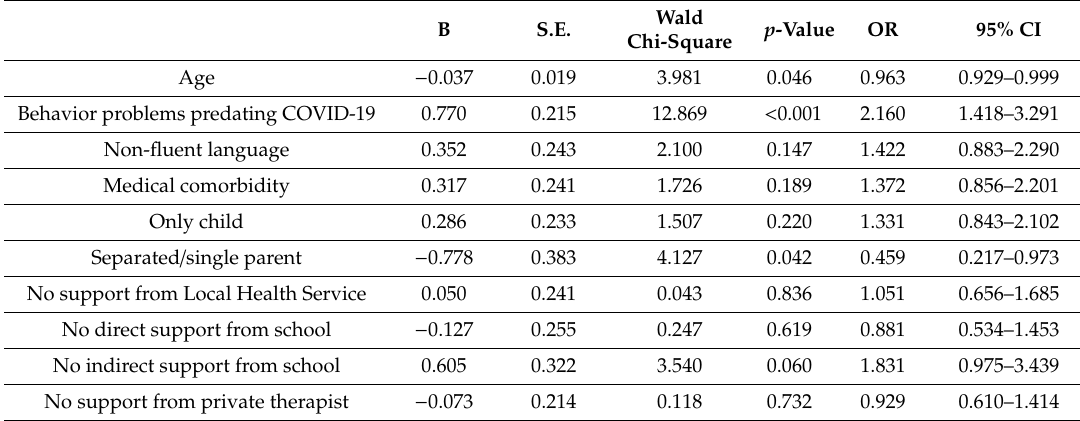
Table 3. Predictors of emergency outbreak negative impact on intensity of behavior problems.